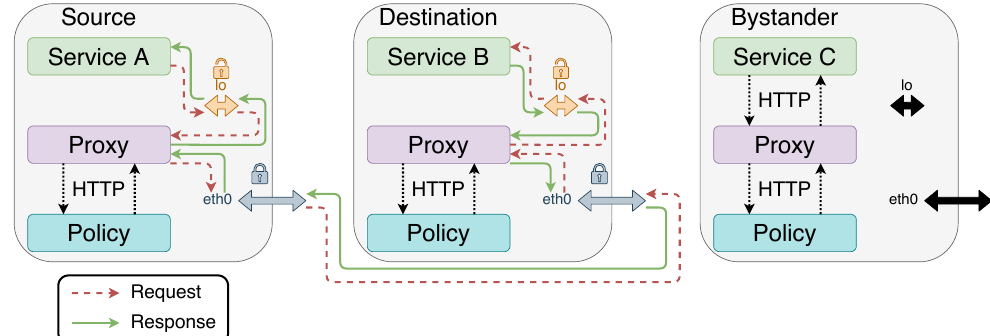
Figure 4. Detailed view of pods and the communication flow. Traffic is unencrypted on the loopbacks, but encrypted on the external